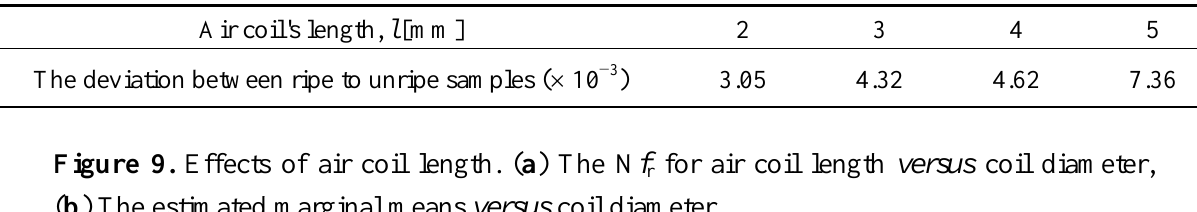
Table 6. The deviation between the mean values of ripe samples and unripe samples.